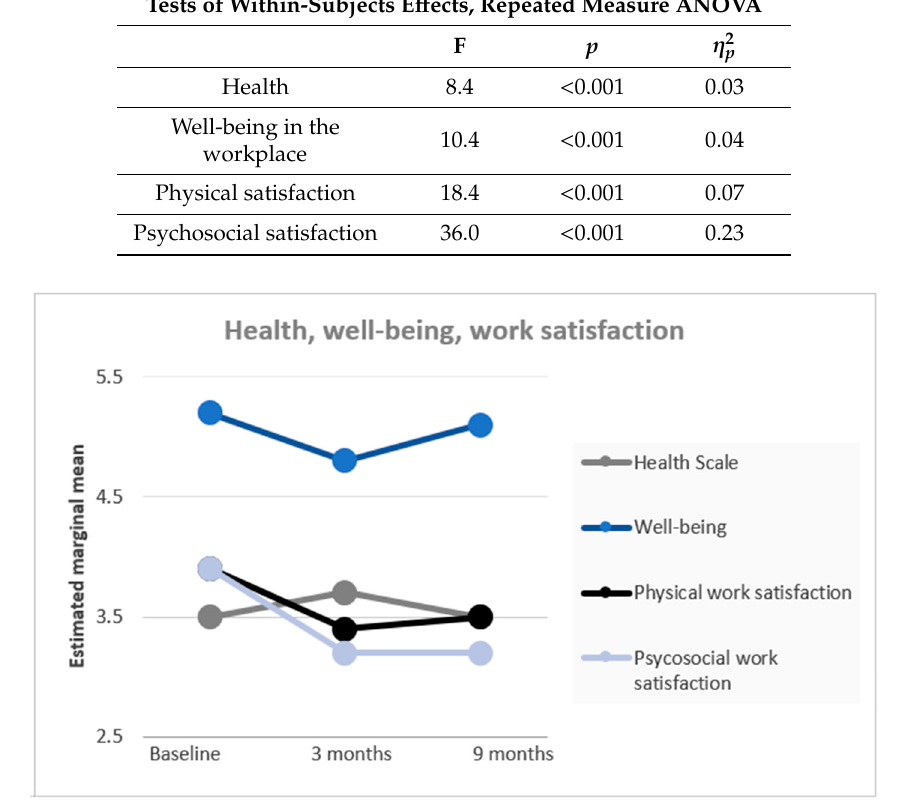
Figure 3. Estimated means (repeated measures ANOVA) of health, well-being (scale 1–7), and work satisfaction (scale 1–5) at baseline, 3 months, and 9 months after the implementation of activity-based workplaces ( n = 246). Table 2. Repeated measure ANOVA comparing health, well-being, and work satisfaction between baseline, 3 months, and 9 months after relocation ( n = 246).